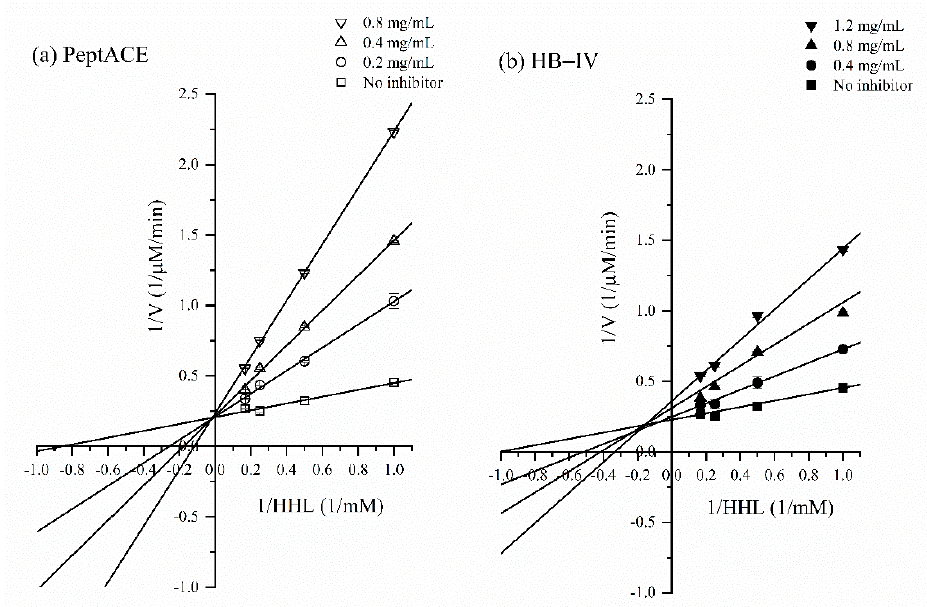
Figure 6. The Lineweaver–Burk plots for the inhibition of ACE by different concentrations of ( a ) PeptACE and ( b ) HB ‐ IV.